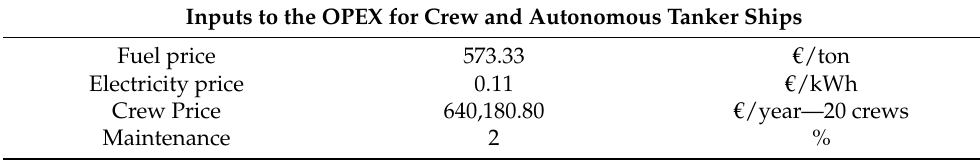
Table 13. OPEX inputs for the SFG and crew and autonomous tanker ships.